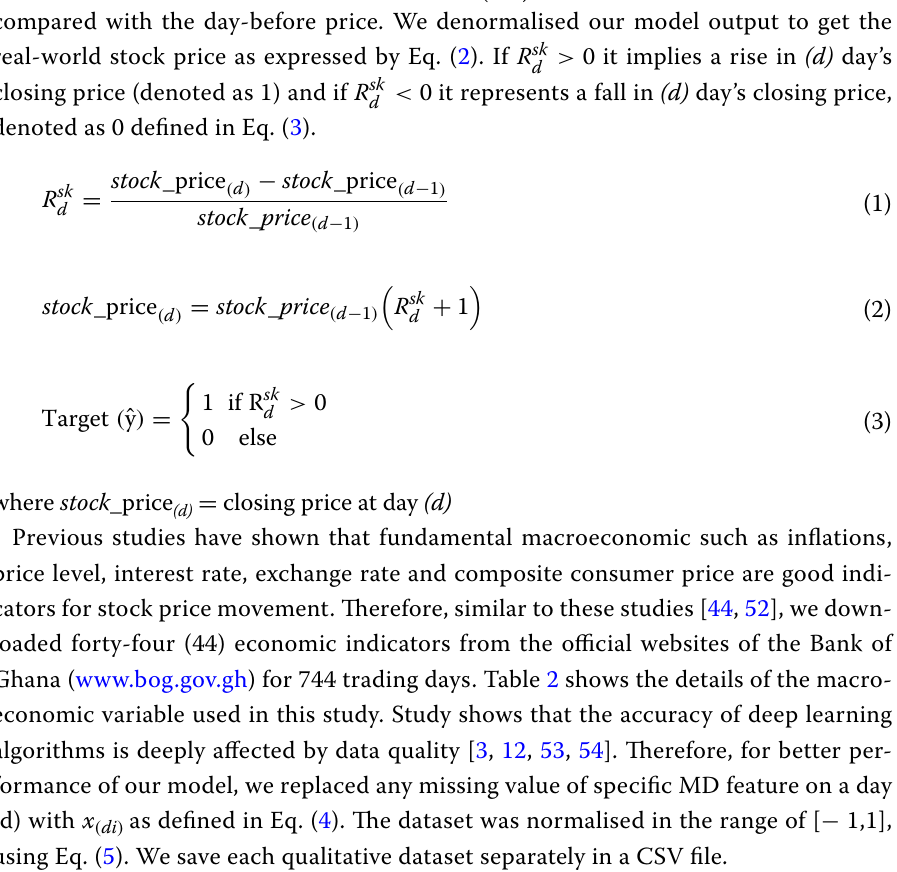
to reflect the stock-price change